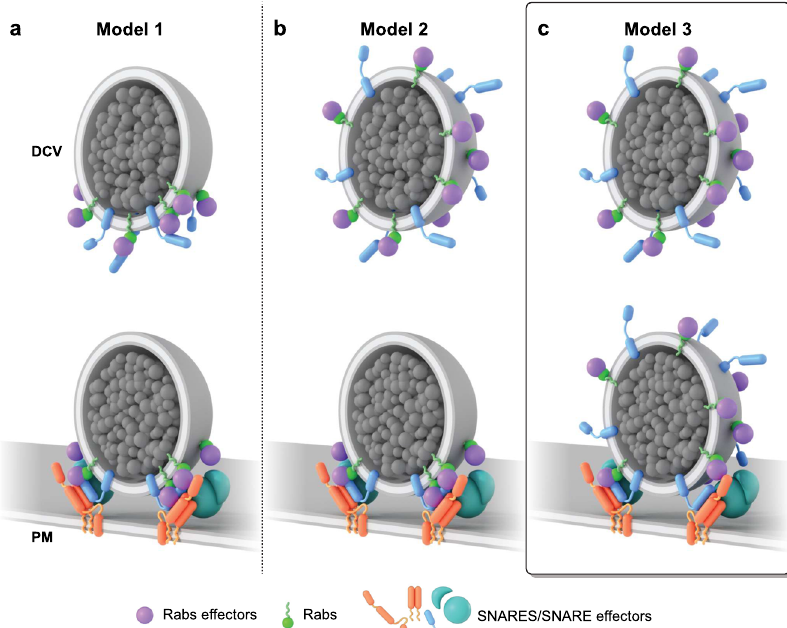
Fig. 7 Architectural models of proteins during docking DCV. Scenarios for the distribution of Rab-GTPases and their respective effector proteins on a DCV. a Model 1: Rab-effector complexes on DCVs concentrate before and after vesicle docking. b Model 2: A hypothetical model shows a universal distribution of the Rab protein complexes, which diffuse, and concentrate at the docking site. c Model 3: Hypothetical model generated from our work proposes a global distribution of Rab protein complexes before and after docking that promotes ef fi cient capture, docking, and recapture of DCVs at the plasma